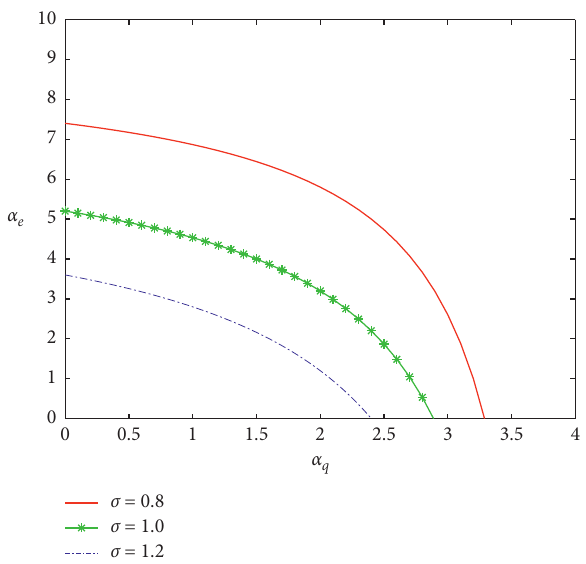
Figure 3: The evolution process of dynamic system (25) with different parameter ( σ )